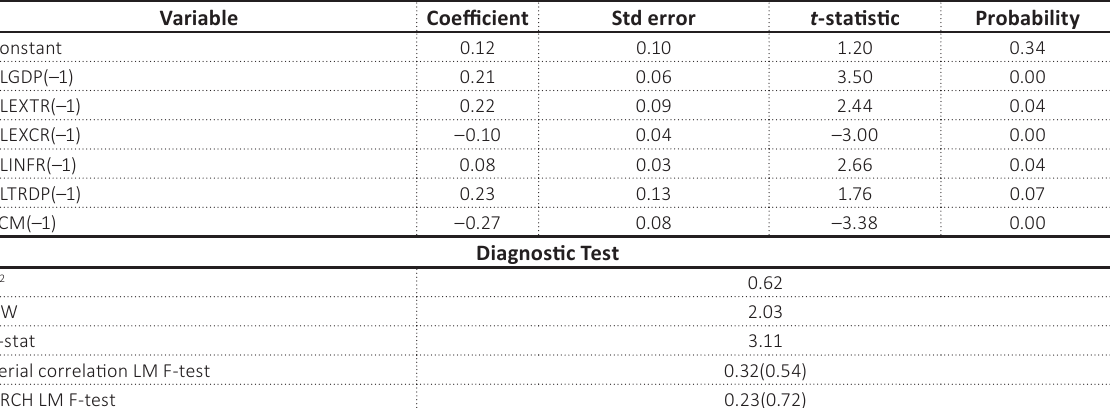
Table 5. Estimated